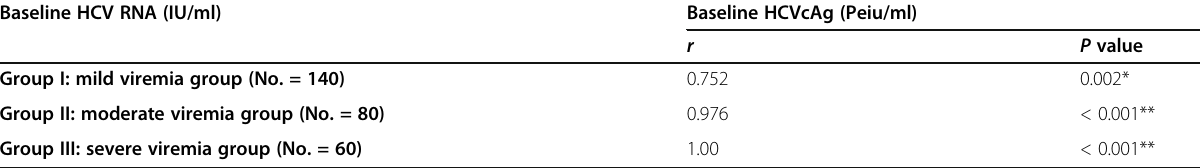
Table 3 Correlation between baseline levels of HCVcAg (Peiu/ml) and HCV RNA (IU/ml) assays among the studied groups Baseline HCV RNA